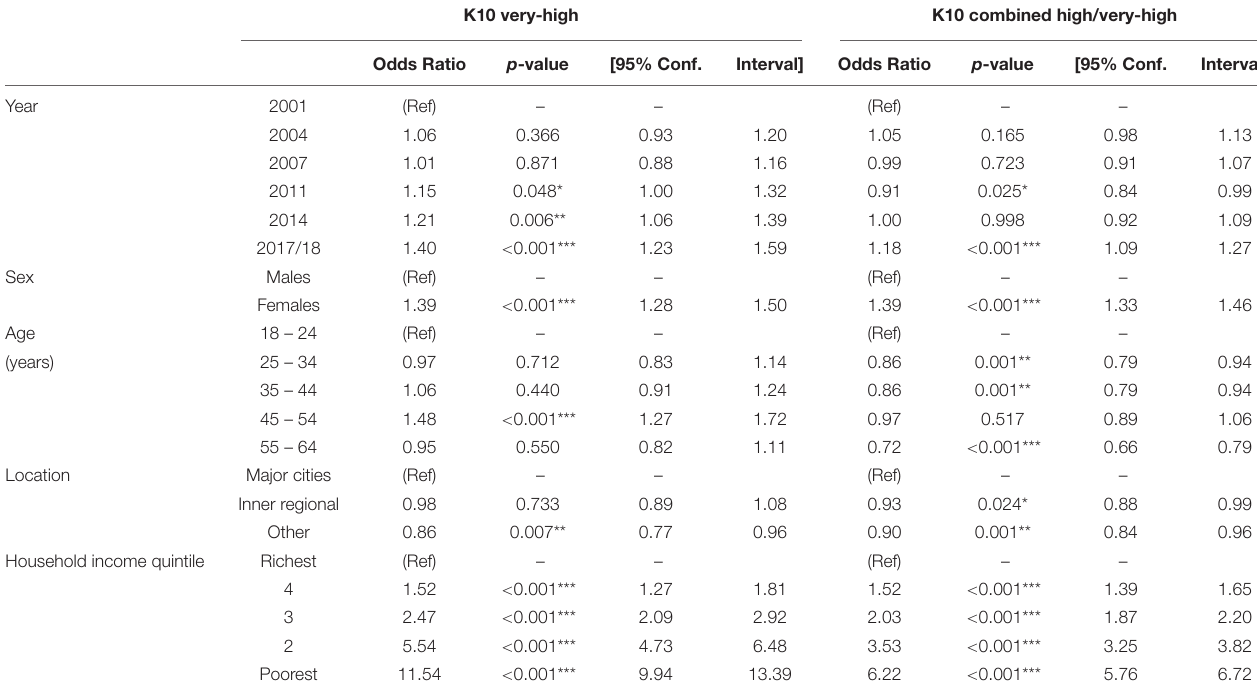
TABLE 2 | Odds ratio of psychological distress adjusted for year, sex, age, residential location, and household income. K10 very-high K10 combined high/very-high Odds Ratio p -value [95% Conf. Interval] Odds Ratio p -value [95%